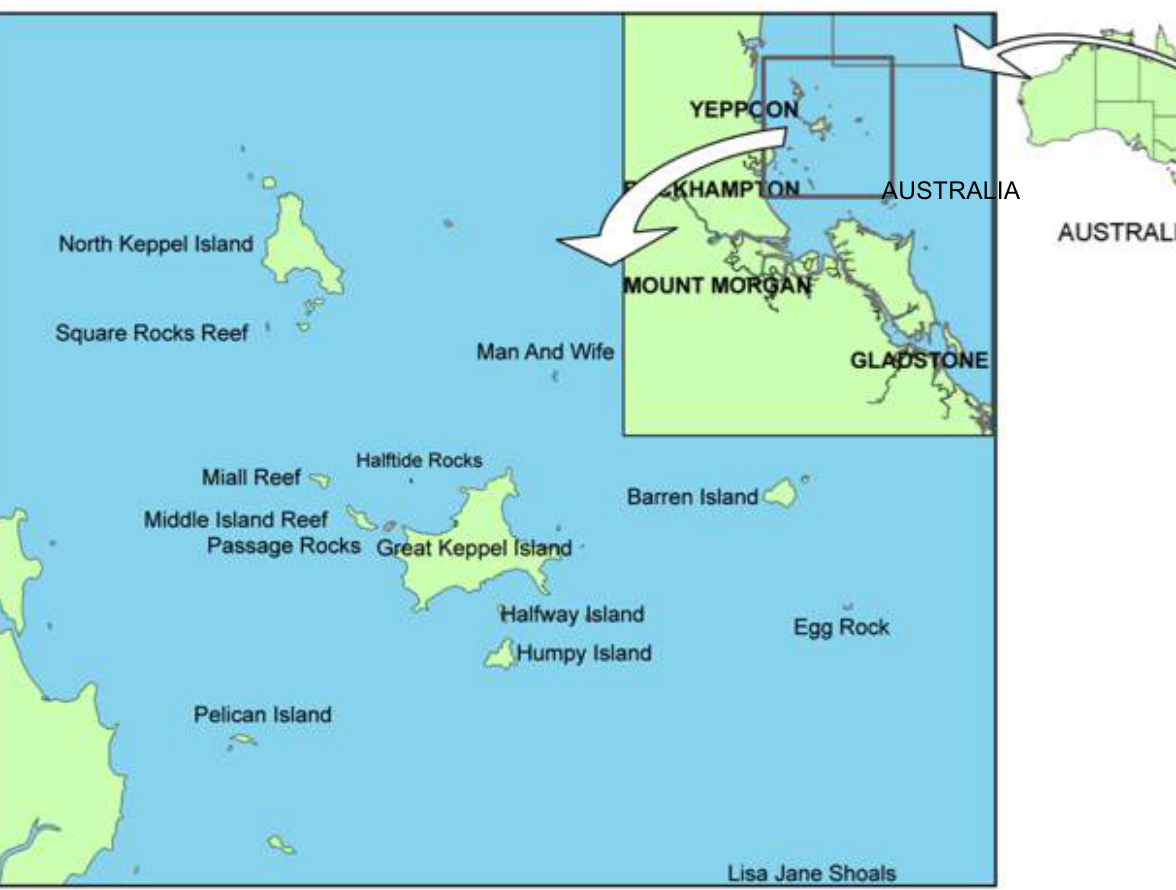
Figure 1. Map of the Keppel Islands group in the southern Great Barrier Reef on the central coast of Queensland, Australia. The Keppel group lies off the coast of central Queensland adjacent to the townships of